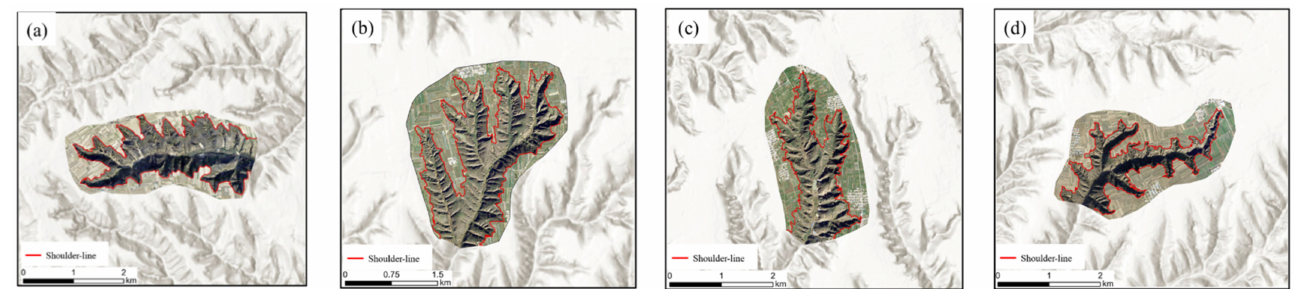
Figure 13. Results of improved shoulder line: ( a – d ) represent 4 sample areas.